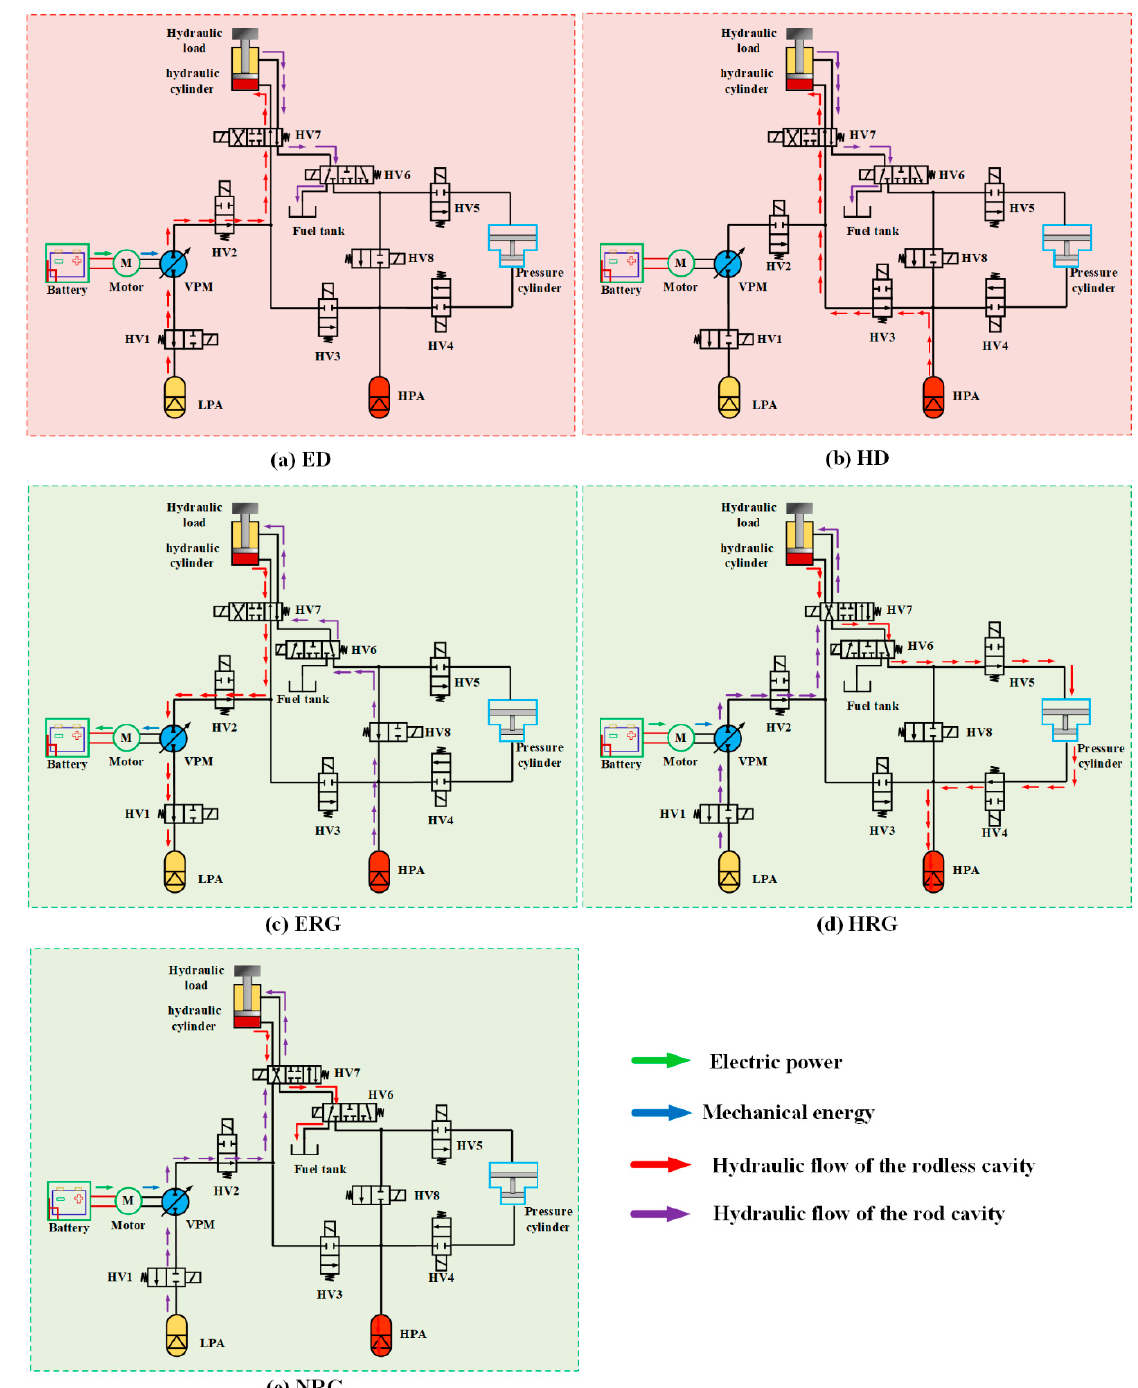
Figure 2. Working principle of the EHDR-EEB: ( a ) ED; ( b ) HD; ( c ) ERG; ( d ) HRG; ( e ) NRG.